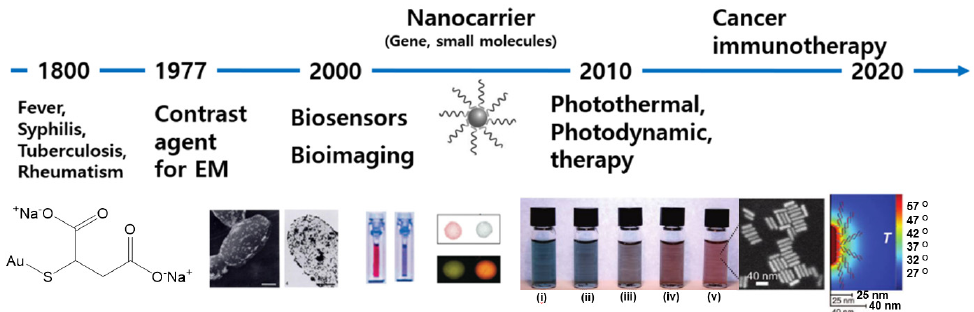
Figure 1. Timeline showing changes in the applications of AuNPs in the field of nanomedicine.